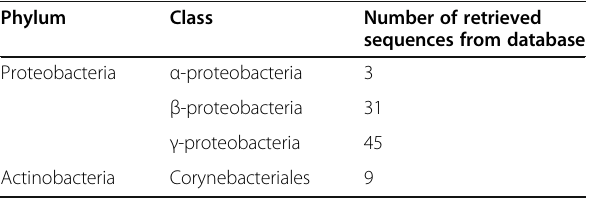
Table 1 Taxonomic characterization of bacterial strains used for degenerate primer